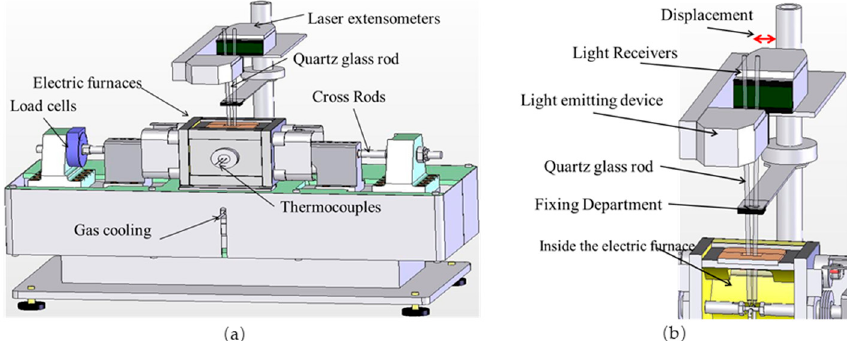
Figure 2. Laboratory equipment. ( a ) Equipment appearance; ( b ) dimensional measuring instruments.